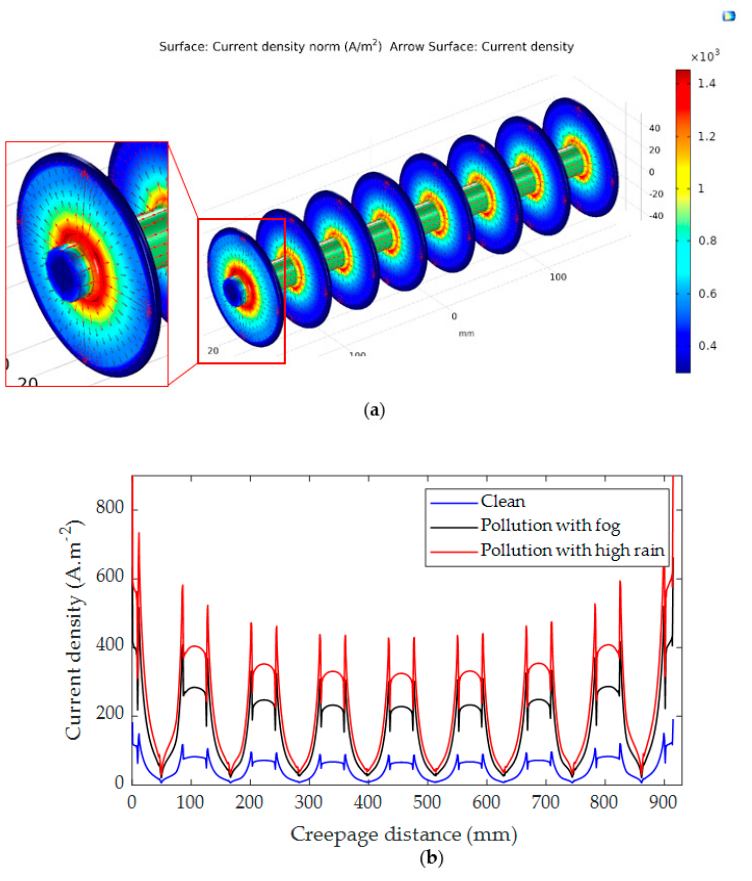
Figure 18. Current density distribution for insulator type I: ( a ) 3-D simulation view; ( b ) Current density distribution along the insulator.